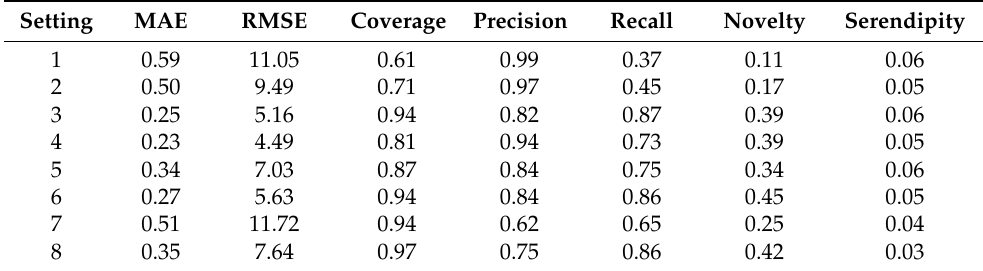
Table 4. RS performance measurements with total data.